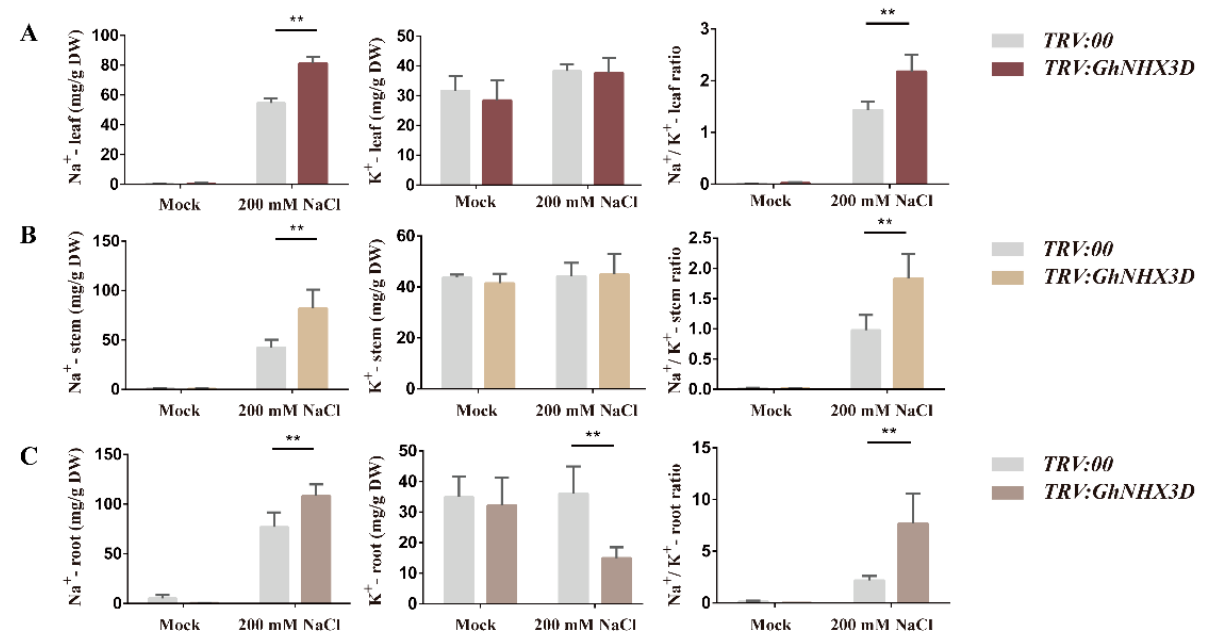
Figure 6. Changes in Na + and K + contents and Na + /K + ratio in organs of TRV:GhNHX3D and TRV:00 cotton plants under salt stress. ( A ) leaves; ( B ) stems; ( C ) roots. Data are means ± standard deviation of three biological replicates. Significant differences between groups (Student’s t -test): **, p < 0.01.